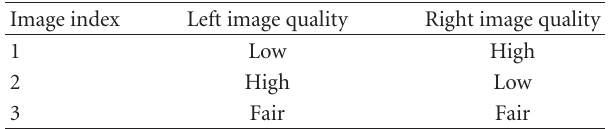
Table 4: PLCC, SRCC, KRCC, AAE, and RMSE values (after nonlinear regression) of testing and training groups in [3]